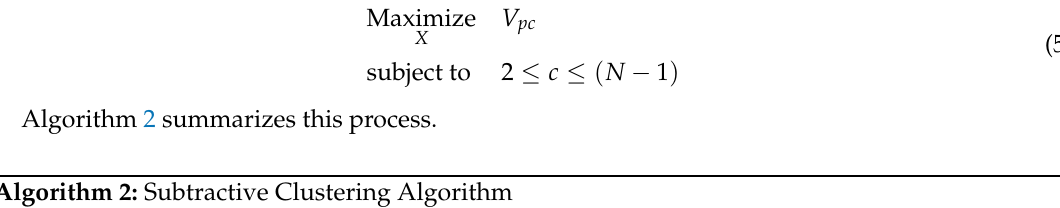
Algorithm 2: Subtractive Clustering